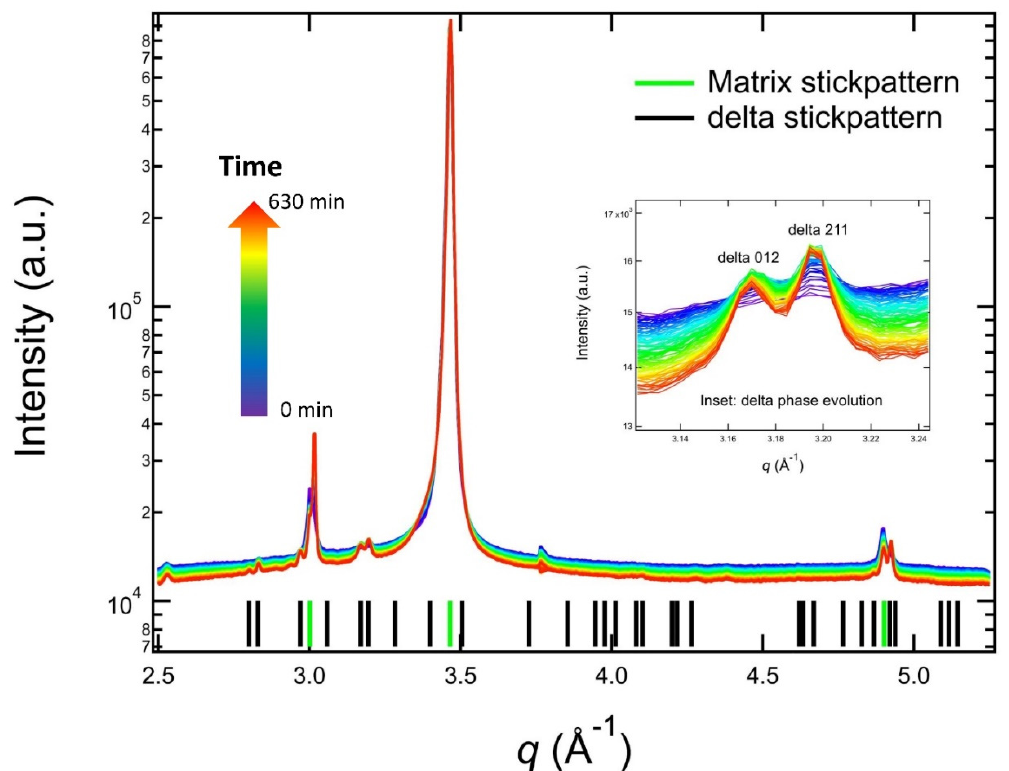
Figure 3. In situ synchrotron XRD data acquired during an isothermal heat treatment of AM IN625 at 700 °C. The inset shows the evolution of the δ 012 peak and δ 211 peak. The data acquisition time follows the arrowed color scale. The calculated stick patterns correspond to an FCC matrix phase and an orthorhombic δ phase.